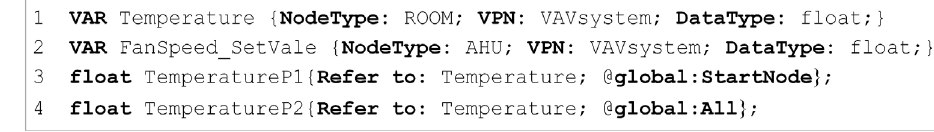
Figure A2. Sample code for defining field-oriented variables and parameters.